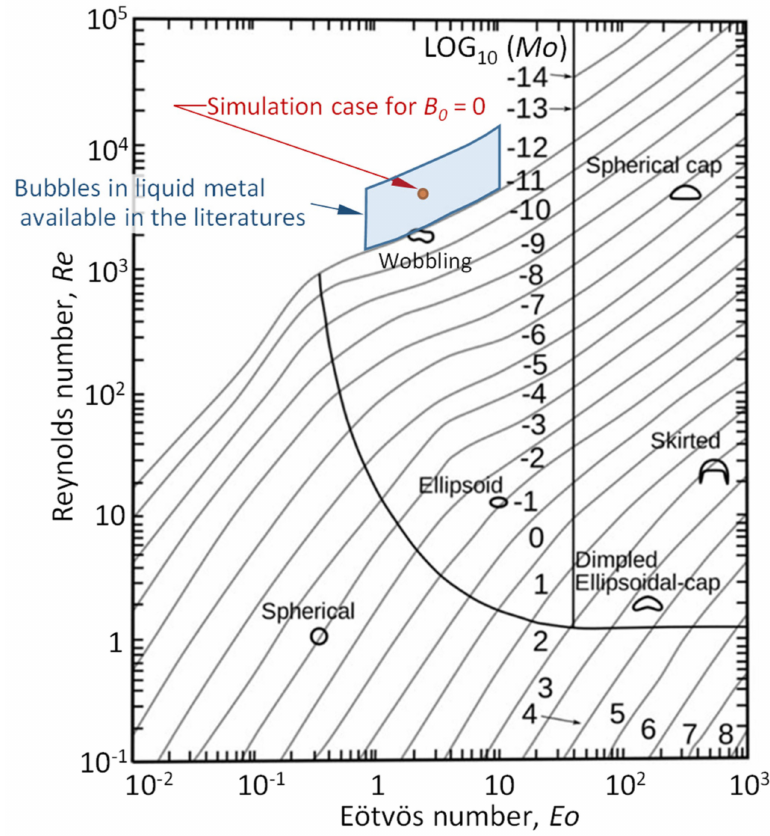
Figure 20. Bubble characterization for B 0 = 0 in the diagram of Grace, et al. [47]. The simulation result for B 0 = 0 corresponds to the wobbling